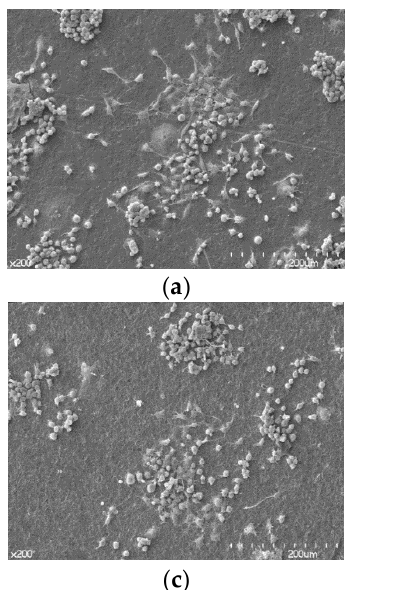
Figure 5. Scanning electron microscopy images showing differentiated osteoclasts that were seeded on the Ti disk and the zirconia disk. ( a ) Cells seeded on a Ti disk, original magnification 200×; ( b ) original magnification 2000×; ( c ) Cells seeded on a zirconia disk, original magnification 200×; ( d ) original magnification 2000×.